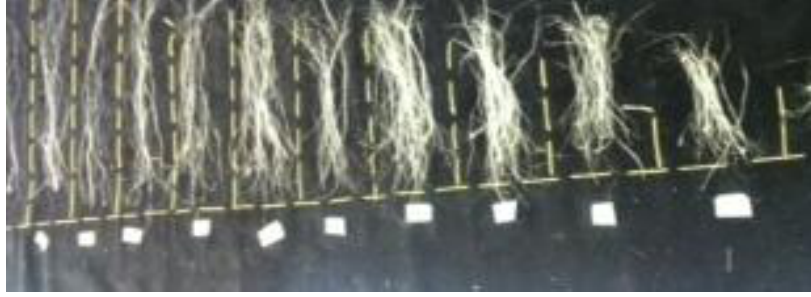
Figure 2 . Flax fiber separated in different classes of length 0–2 cm (extreme right) to 68–70 cm (extreme